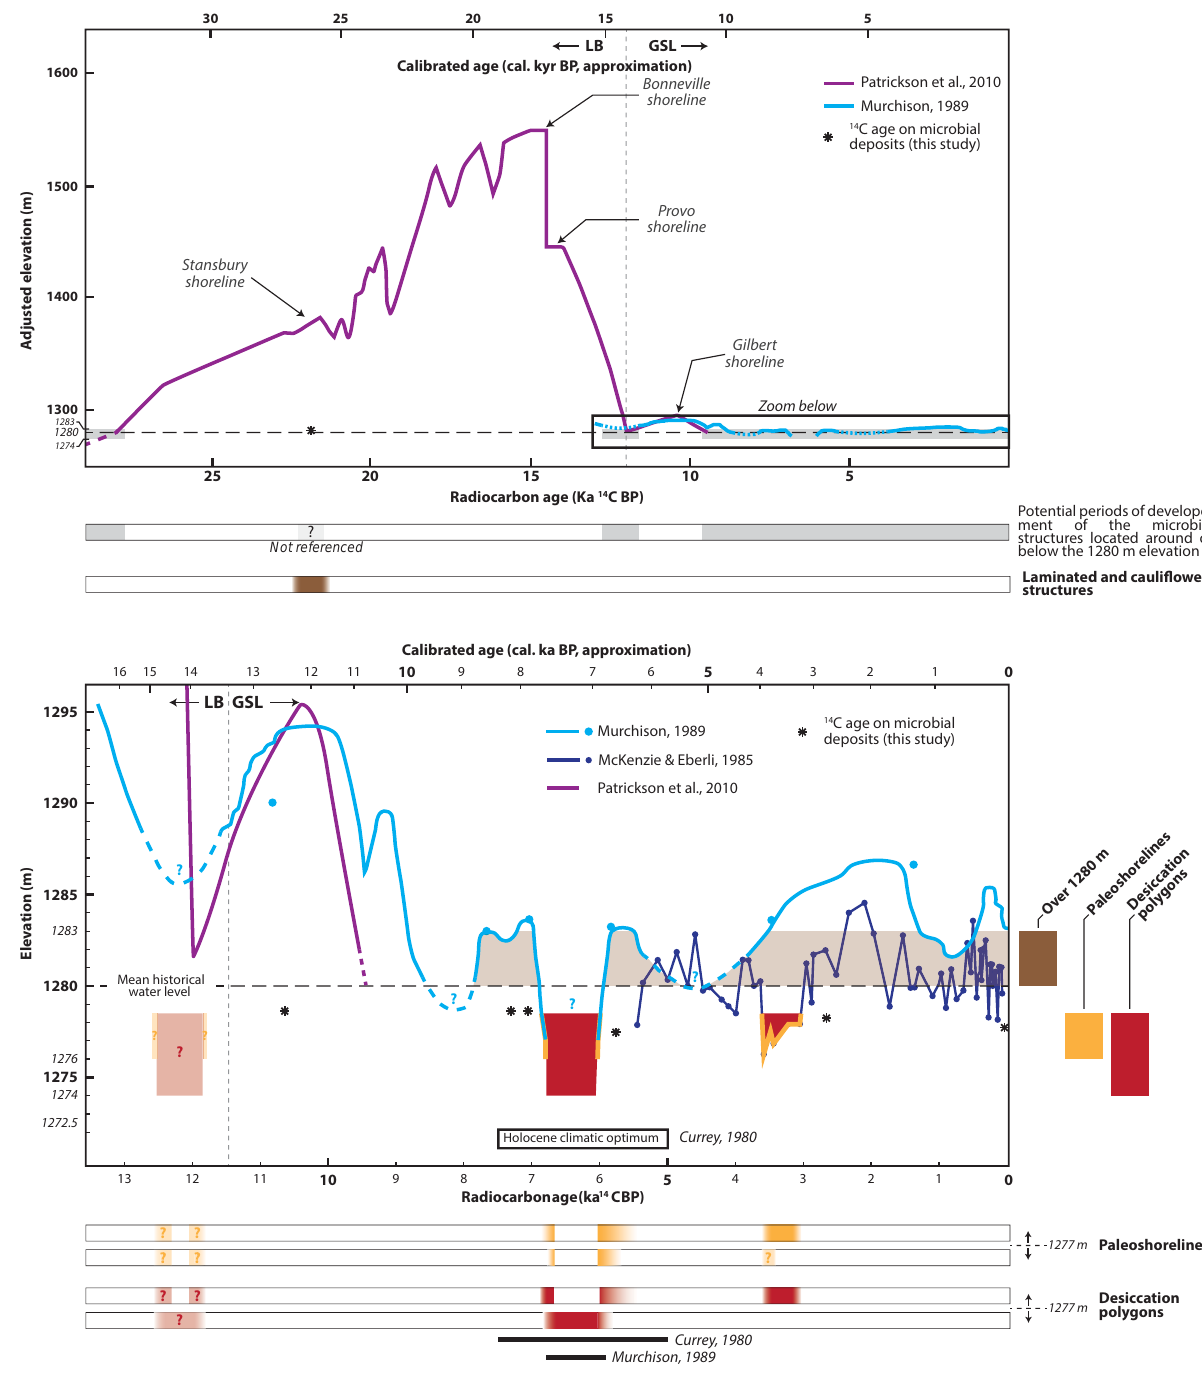
Figure 7. Reconstitution curve of the water level at Lake Bonneville and the Great Salt Lake showing potential periods of formation of the fossil microbial structures (brown), paleoshorelines (yellow) and desiccation polygons (red).